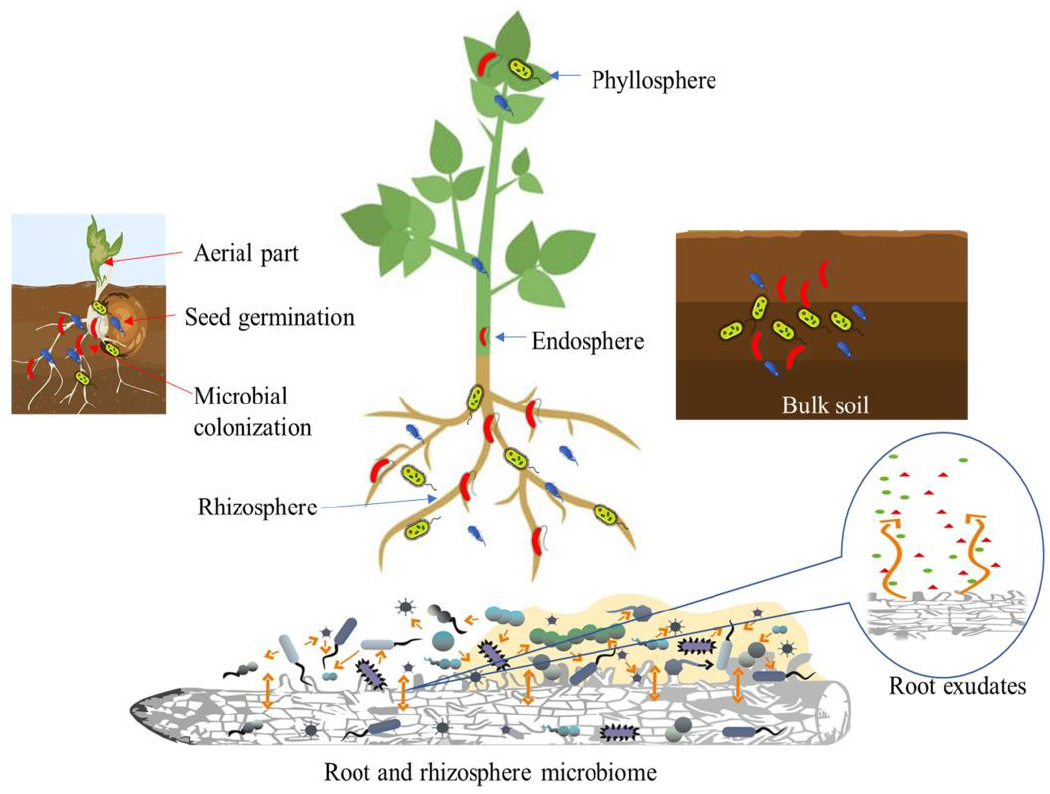
Figure 1. Plant–microbe interaction: regions involved in the development of plant Figure 1. Plant – microbe interaction: regions involved in the development of plant microbiome.